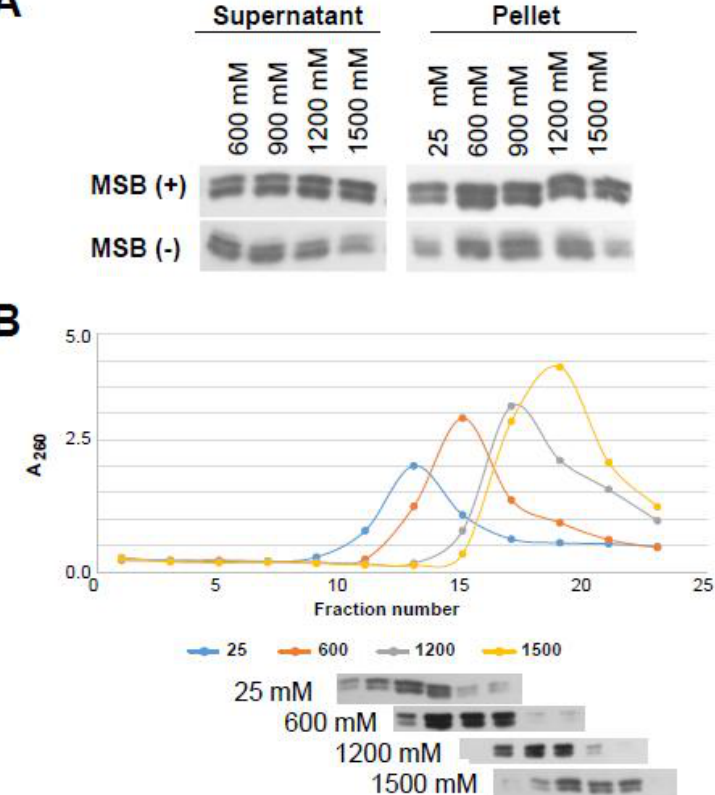
Figure 7. Ionic (NaCl) strength-dependent affinity of H2A.Z-1 and H2A.Z-2 chicken isoforms in A) chromatin and B) nucleosomes.